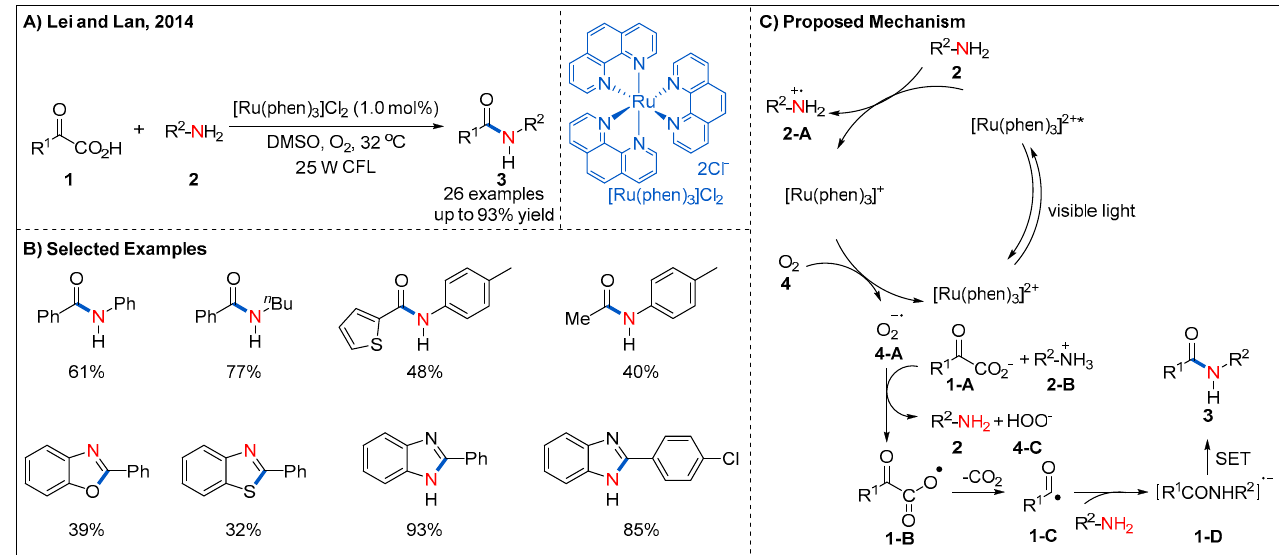
Figure 4. Visible-light-mediated decarboxylation/oxidative amidation of α -keto acids.